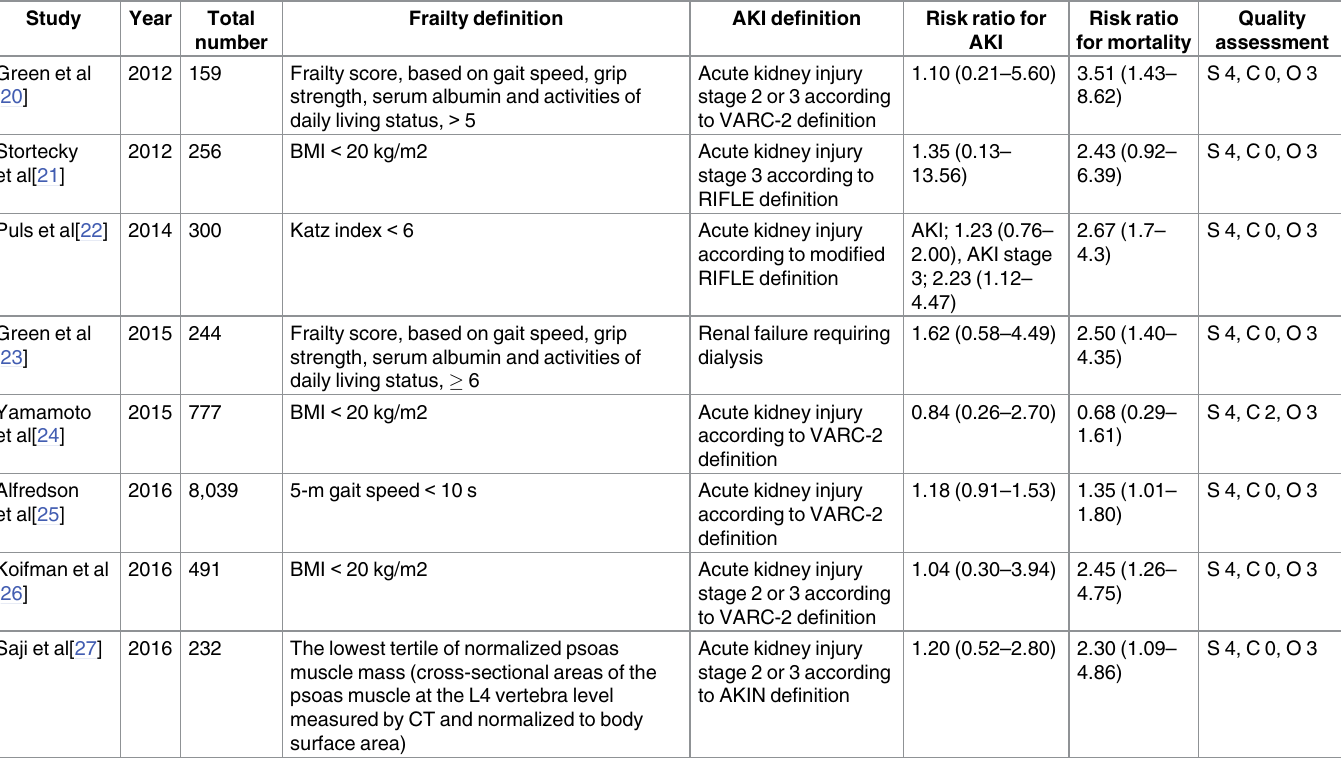
Table 1. Main characteristics of the studies included in this meta-analysis[20–27].